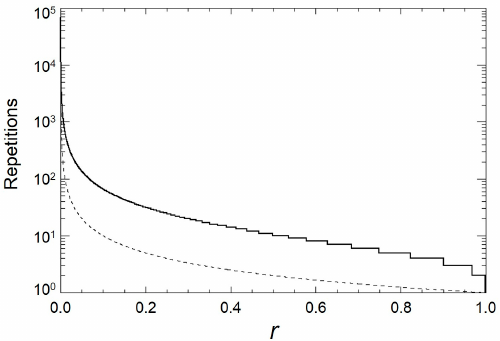
Figure B1. Number of repetitions as a function of r for r ’ exceeding 99.9% (solid line) and the expected number of repetitions for finding three correct pairs for the first time (dashed line). Both reduce as r approaches to 1.